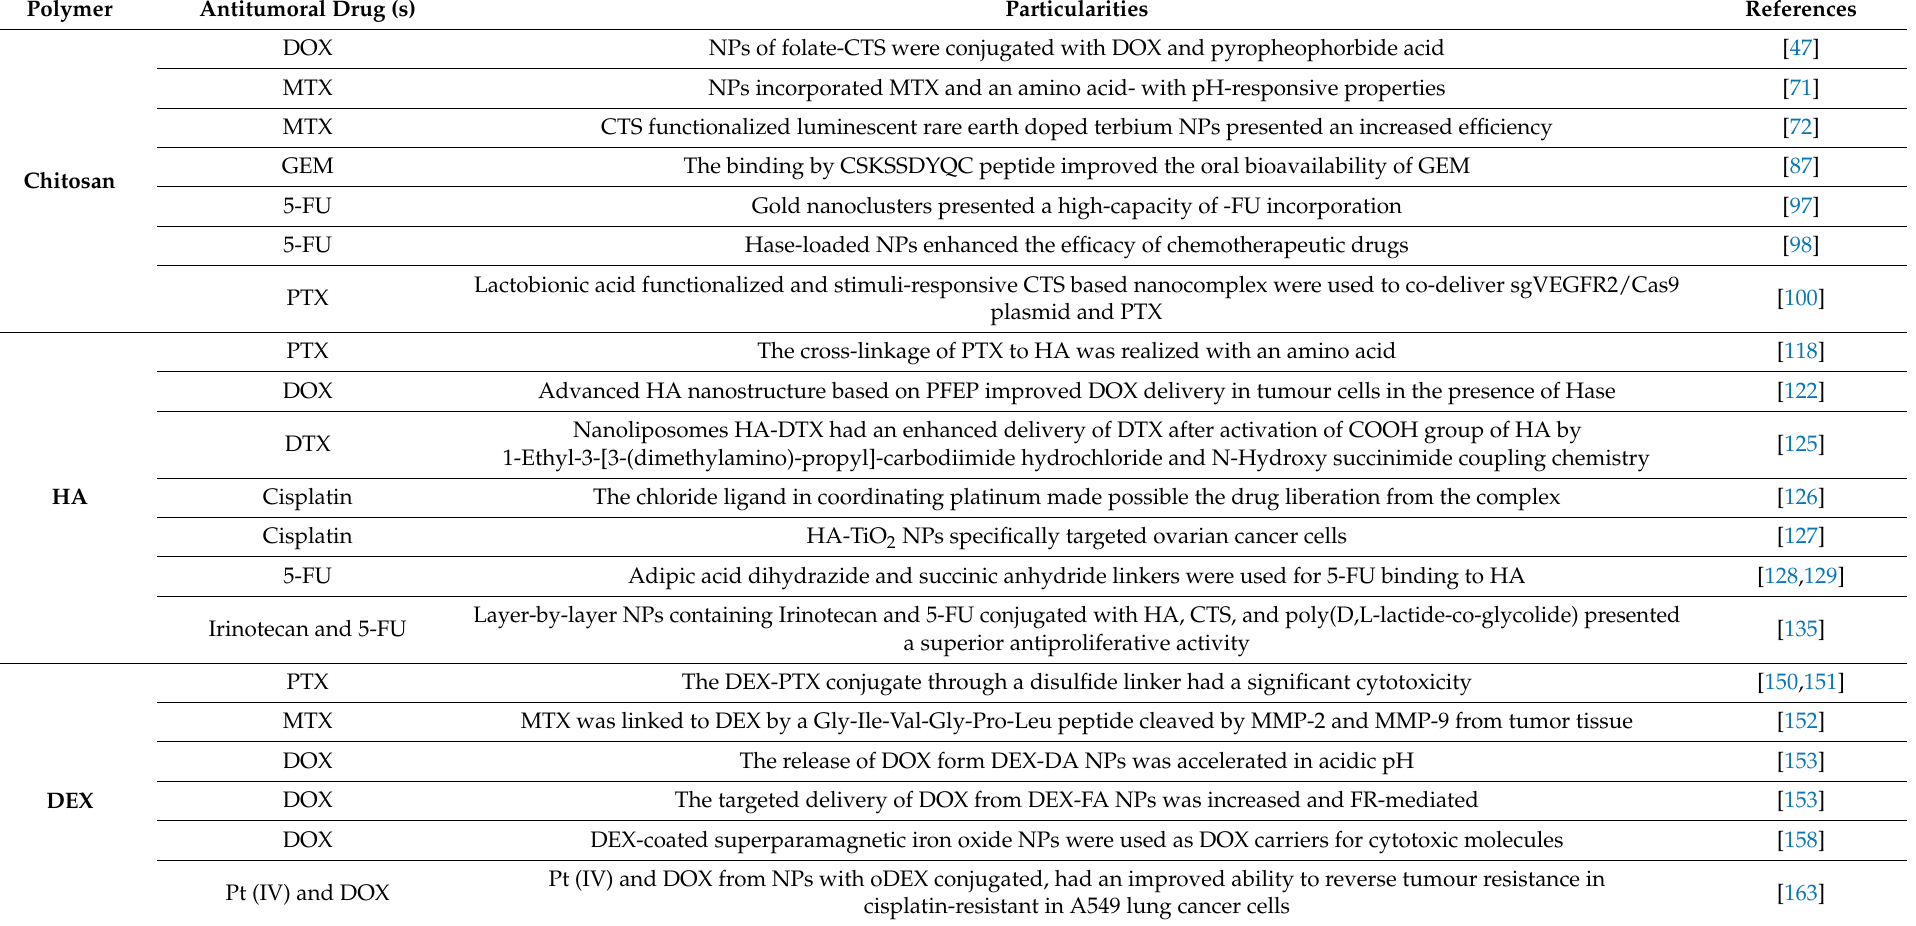
Table 1. The summarizing of particularities of polymer–cytotoxic drug conjugates.